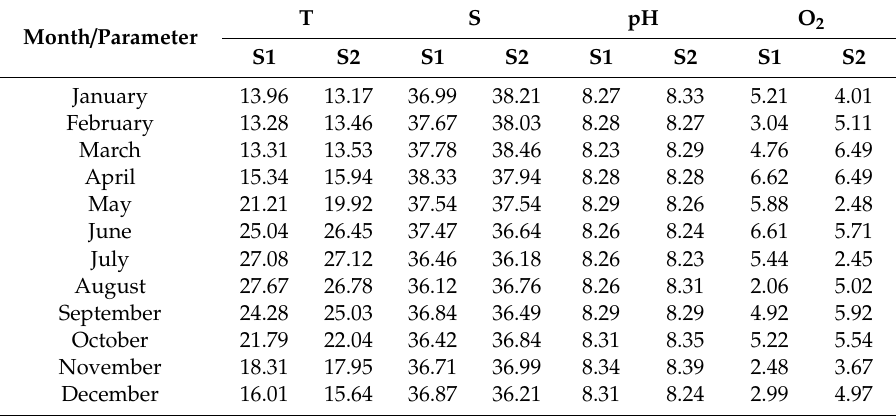
Table 1. Monthly values of the recorded environmental parameters, temperature T ( ◦ C), salinity S (psu) pH, and dissolved oxygen O 2 (mg / L) in the sampling stations (S1 and S2) of Pagasitikos